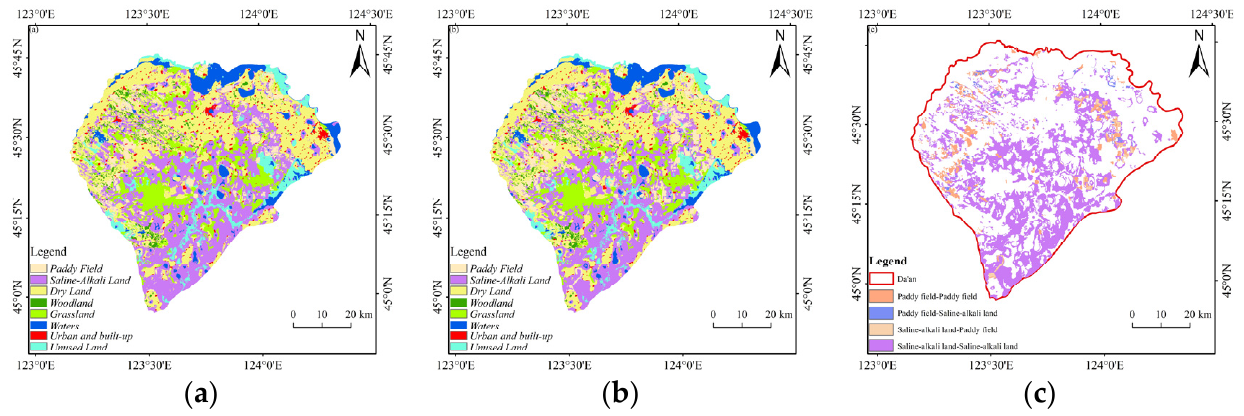
Figure 3. 2015 ( a ) and 2021 ( b ) land use map of Da’an City, 2015 to 2021 ( c ) land use change pattern map.